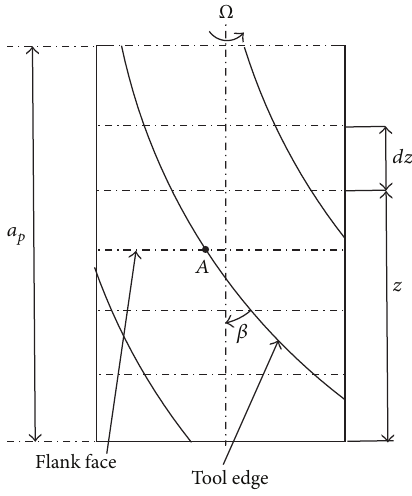
Figure 3: Digitized end mill